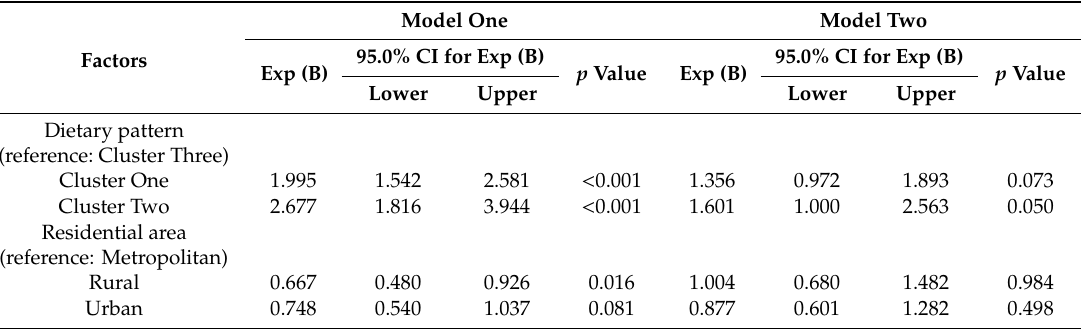
Table 3. Factors a ff ecting grip